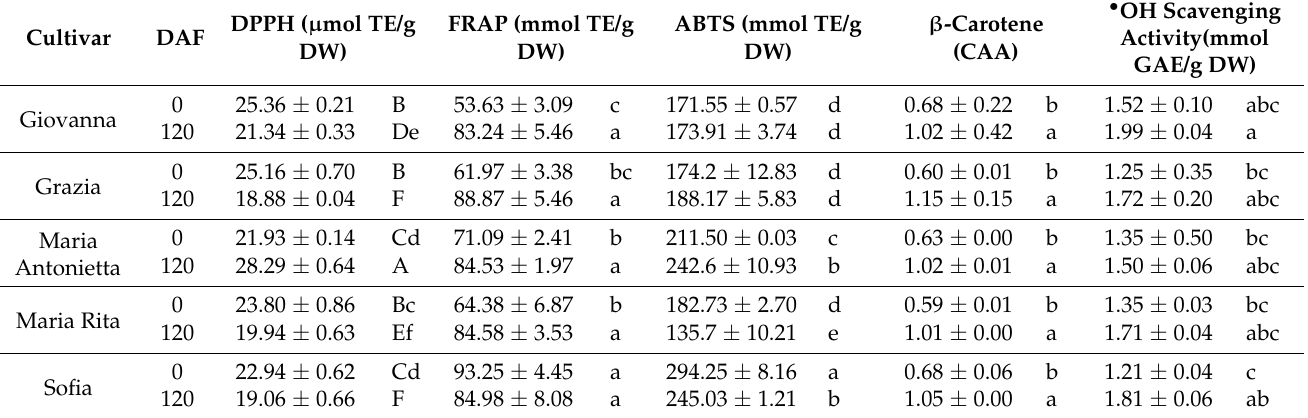
Table 5. Antioxidant activity (AA) in myrtle leaves cultivar evaluated by DPPH, FRAP, ABTS, β -Carotene and EPR assays. Data are the mean and standard deviation of three replicate. Values in the same column labelled with the same letters are not significantly different according to Duncan’s multiple range test at p ≤ 0.01